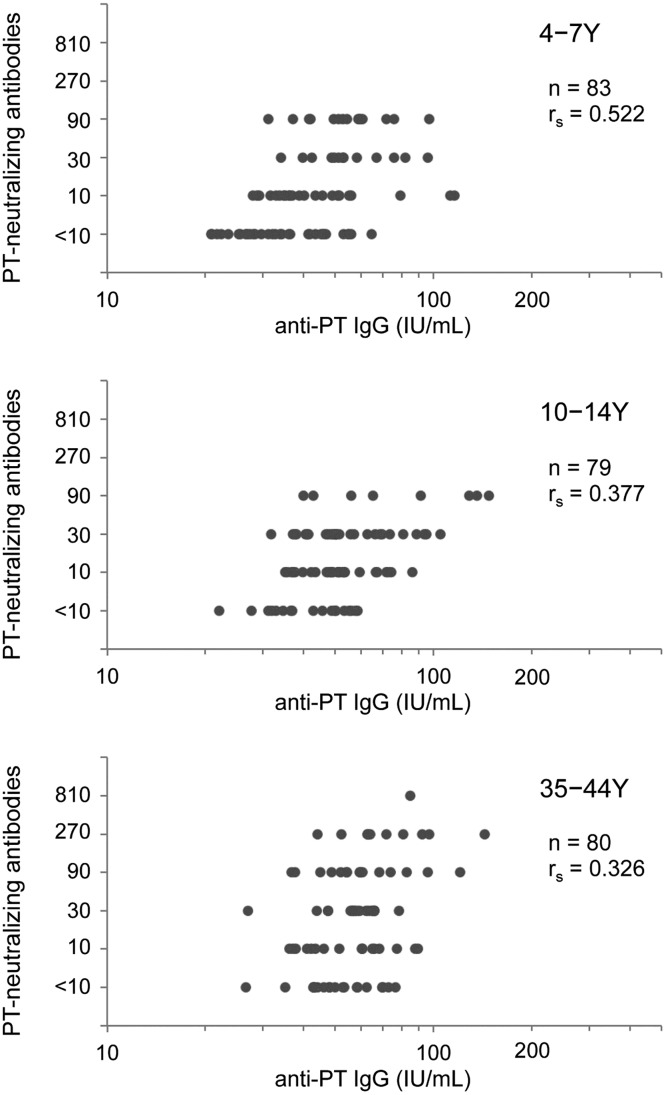
Correlations between anti-PT IgG and PT-neutralizing antibody titers among young children, older children, and adults.Anti-PT IgG titers in individual serum samples (x-axis in log scale) were plotted against PT-neutralizing antibody titers (y-axis). Values on the y-axis indicate the reciprocal serum dilution required to neutralize PT activity. The age groups were 4–7 years, 10–14 years, and 35–44 years. rs, Spearman’s rank correlation coefficient; Y, years.